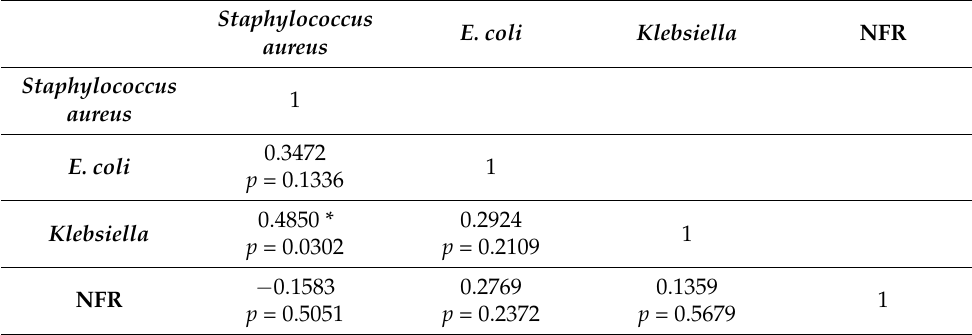
Table 2. Correlations between monthly ciprofloxacin resistance of Staphylococcus aureus, E. coli, Klebsiella and NFR.